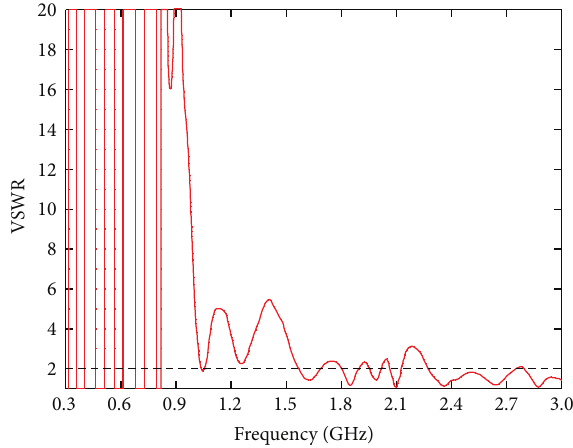
Figure 5: VSWR with a frequency between 300 MHz and 3